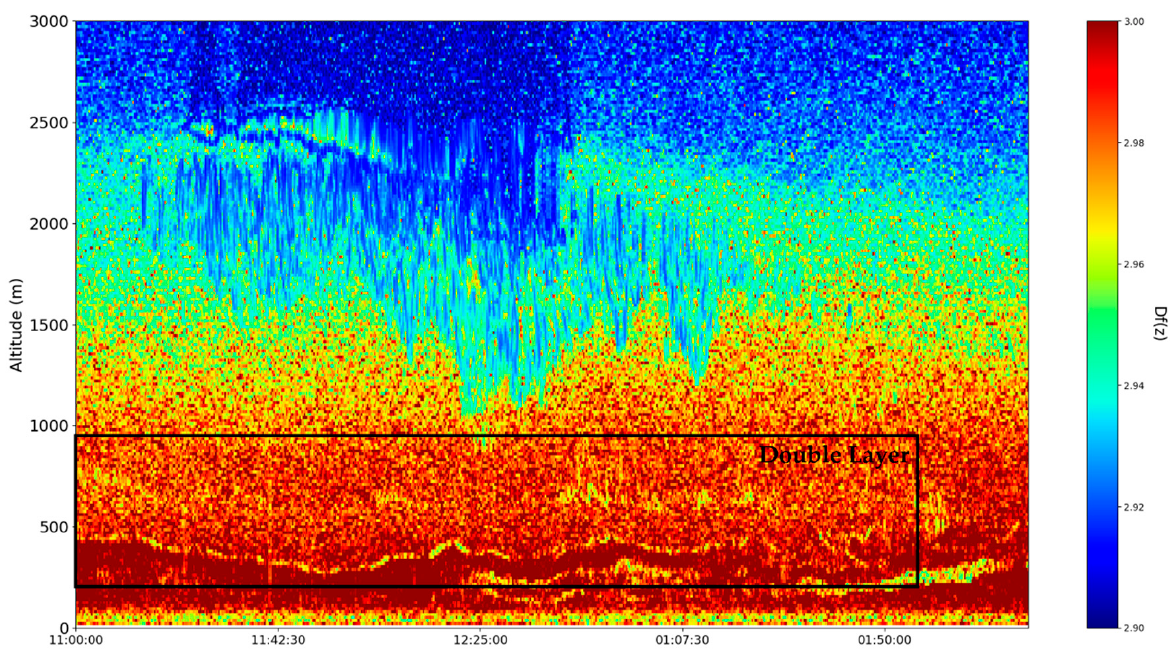
Figure 24. Zoomed-in (region of interest) D f time series, λ = 1064 nm, Gala ț i, Romania, 22 December 2021.